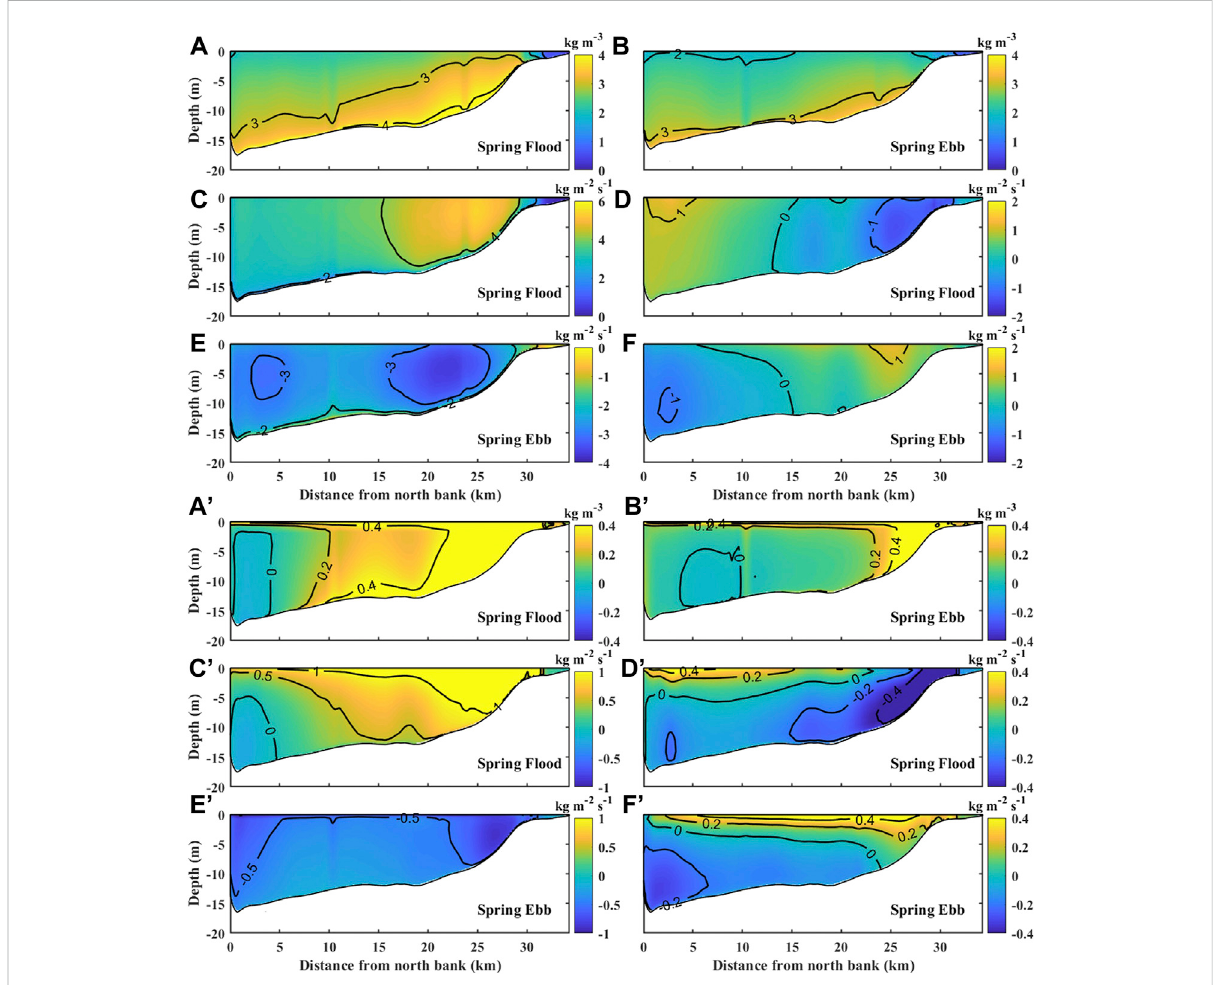
FIGURE 7 SSC at section C1 during spring (A) fl ood tide and (B) ebb tide. Along-estuarine and lateral sediment fl uxes in section C1 (C,D) during spring- fl ood tide. (E,F) are the same as (C,D) except for the spring-ebb tide. Positive values indicate landward or southward direction. Difference of SSC at sectionC1duringspring fl ood (A ’ ) andebb (B ’ ) tides between thetestwithTyphoon Mitagandthetestwithonlytidalforcing. Difference ofsediment fl ux at section C1 during spring- fl ood tides between the test with Typhoon Mitag and the test with only tidal forcing: (C ’ ) along-estuarine and (D ’ ) lateral. (E ’ ,F ’ ) are the same as (C ’ ,D ’ ) except for the spring ebb